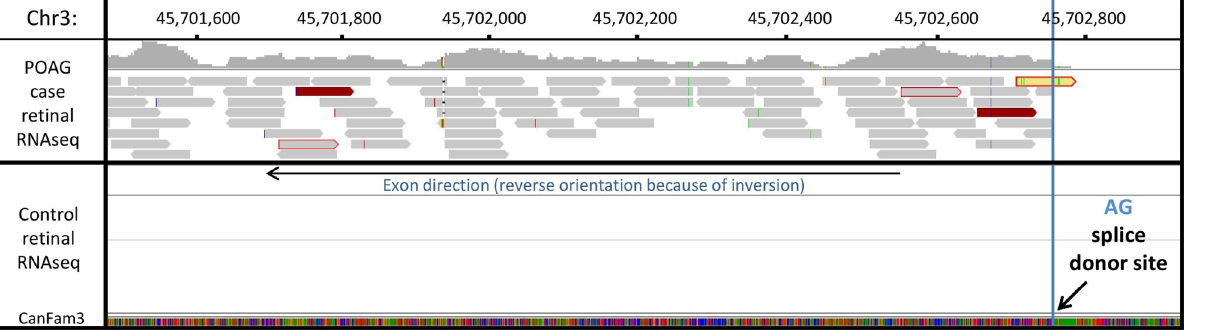
PLOS ONE | DOI:10.1371/journal.pone.0143546 December 18,